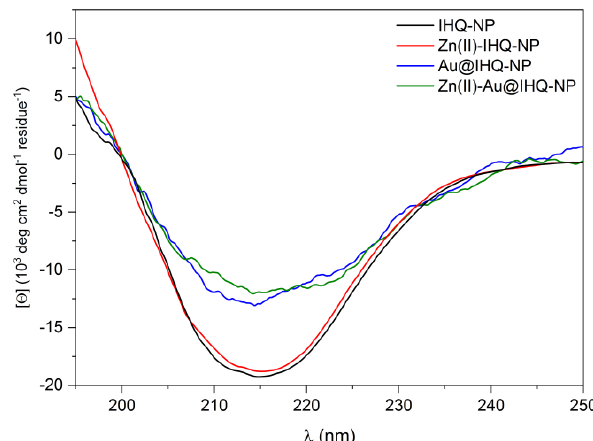
Figure 2. Circular dichroism (CD)-spectra of IHQ-NP and peptide – gold nanoparticle conjugates (Au@IHQ-NP) in absence or presence of Zn(II). CD-spectra were recorded in Tris/HCl buffer pH 8 with 5% acetonitrile at 25 °C in presence of 10 µM (immobilized) IHQ-NP and 100 µM ZnCl 2 , when in presence of Zn(II).